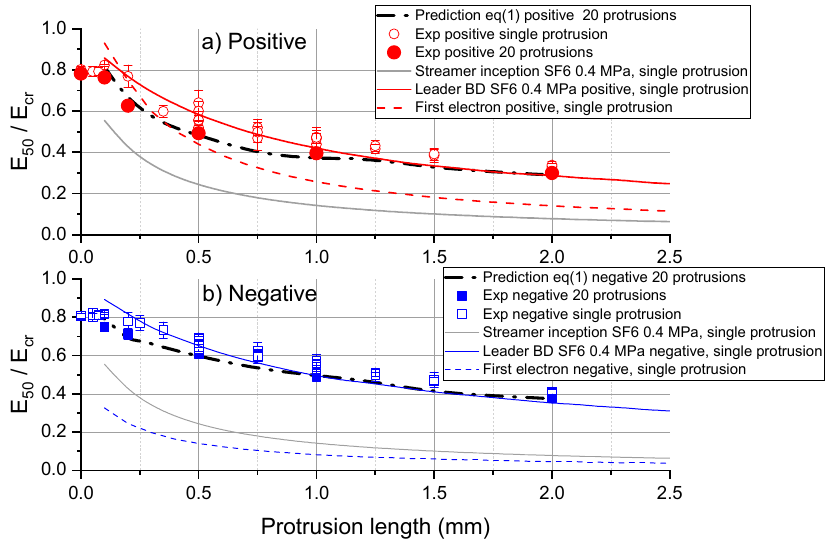
Figure 7. Normalized breakdown fields E 50 / E cr vs. protrusion length L for SF 6 and 20 protrusions. Not all protrusion lengths could be measured when using multiple protrusions at ( a ) positive and ( b ) negative polarities.